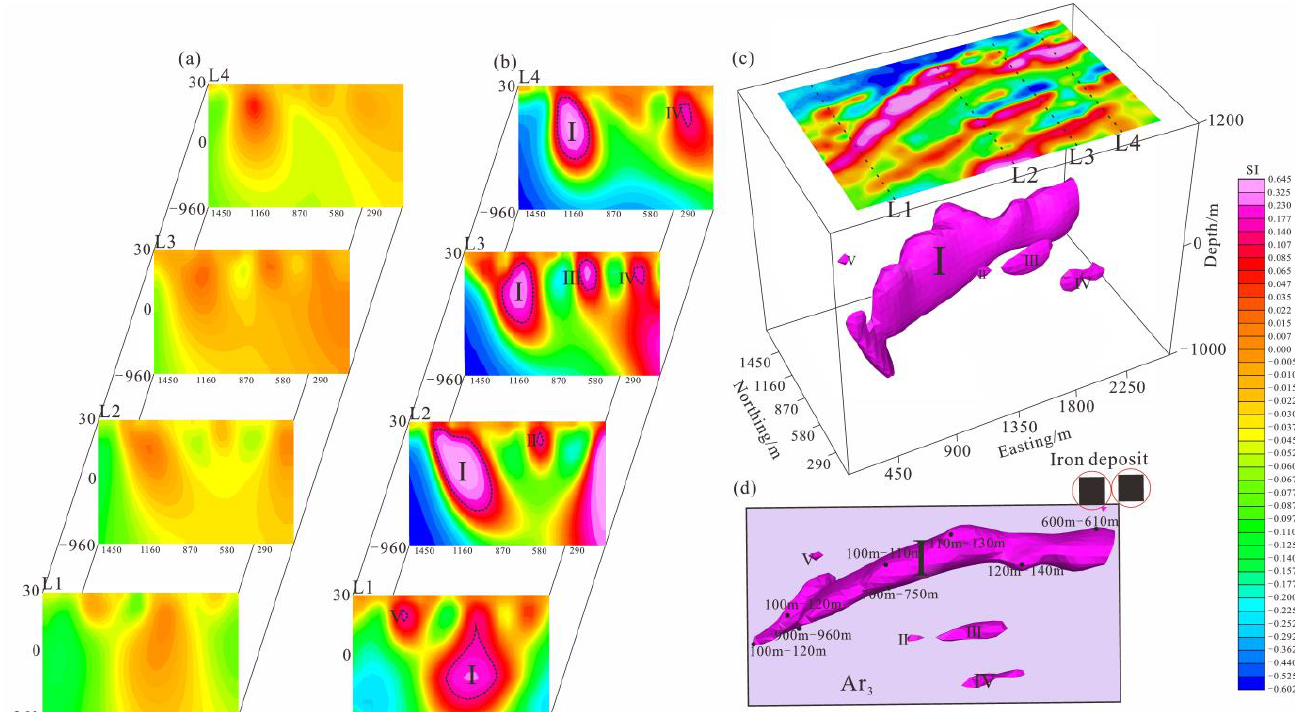
Figure 12. Inversion result of the measured data. ( a ) Magnetic susceptibility slice by the data con- straint joint inversion of the combination matrix ( [ d ∆ T ; d ∆ T ). ( b ) Magnetic suscepti- bility slice by the ICW method. ( c ) 3D inversion result by the ICW method. ( d ) Horizontal range distribution of the high magnetic body.